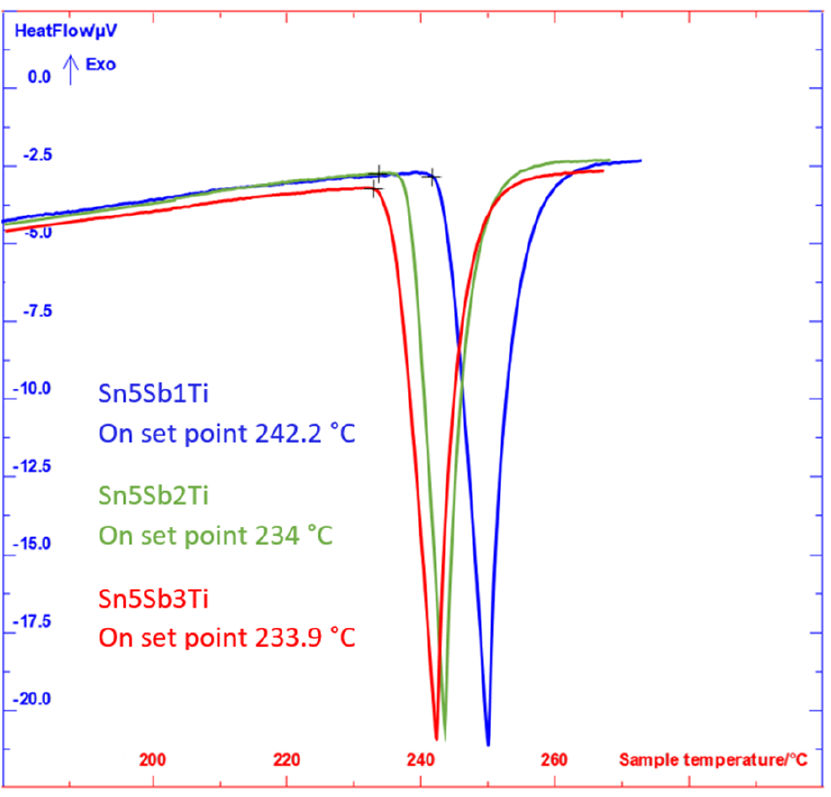
Figure 7. DTA analysis of specimens of soldering alloys of the type SnSb5TiX (2nd measurement). Table 3. The values of phase transformation in Sn5SbXTi solders measured by DTA analysis. Composition Onset Point on Heating ( ◦ C) Onset Point on Cooling Down ( ◦